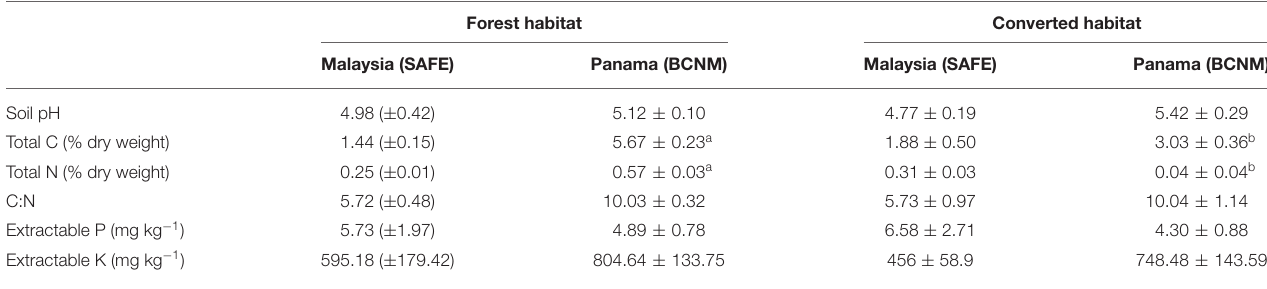
TABLE 2 | Initial soil properties (0–10cm depth) for tropical forest and converted habitats in Malaysian Borneo and Panama, showing total soil carbon (C) and nitrogen (N) concentrations, extractable phosphorus (P), and potassium (K) and soil pH, and soil C to N (C:N) ratios, where SAFE is the Stability of Altered Forest Ecosystems